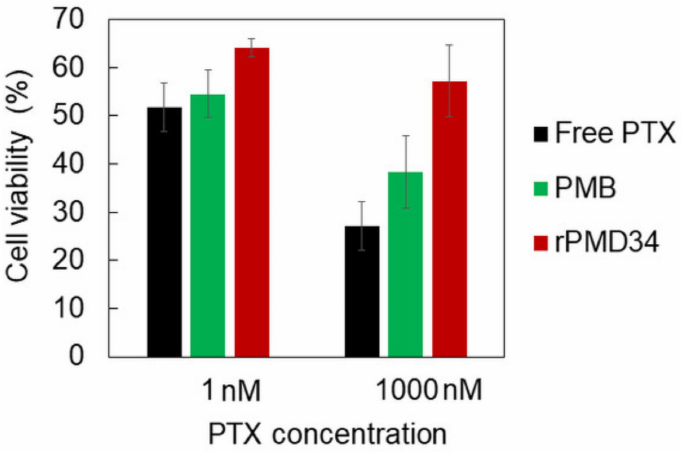
Figure 6. Cytotoxicity of free PTX and PTX solubilized by PMB and rPMD34 (n =